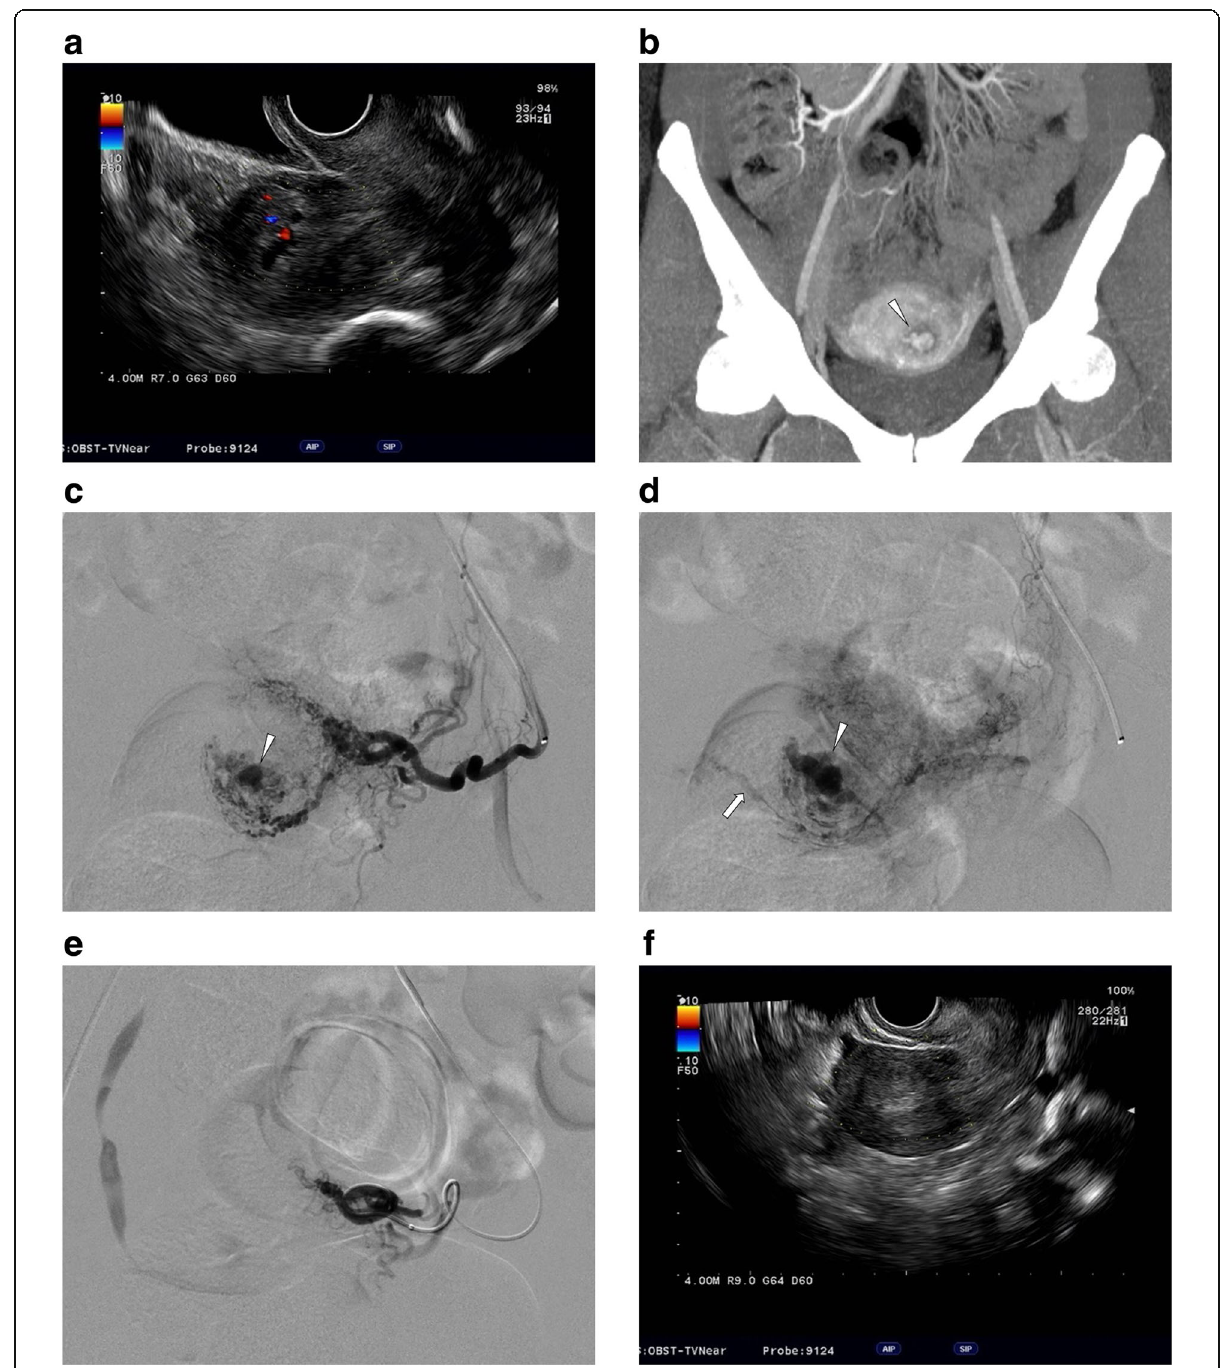
Fig. 1 A 33-year-old woman with vaginal bleeding caused by retained placenta. a. Color doppler TVUS showed vascularity (arrowhead) in the uteroplacental tissue. b. Coronal MIP image of arterial phase CE-CT showed intrauterine vascular mass (arrowhead) fed by left uterine artery. c. Left uterine arteriogram showed dilated vascular channel (arrowhead) in arterial phase uterine arteriography. d. Venous drainage (arrow) from dilated vascular channel (arrowhead) depicted in the capillary phase. Drainage vein connected to right uterine vein in the venous phase. Microcatheter was inserted into the blood sinus feeding artery. Target embolization was performed using GS. e. Post-embolization left uterine arteriography confirmed disappearance of the dilated vascular channel. f. At 2 days after the TAE procedure, the intrauterine hyper vascular lesion disappeared on TVUS. In this case, expectant management after TAE was chosen and no re-bleeding was